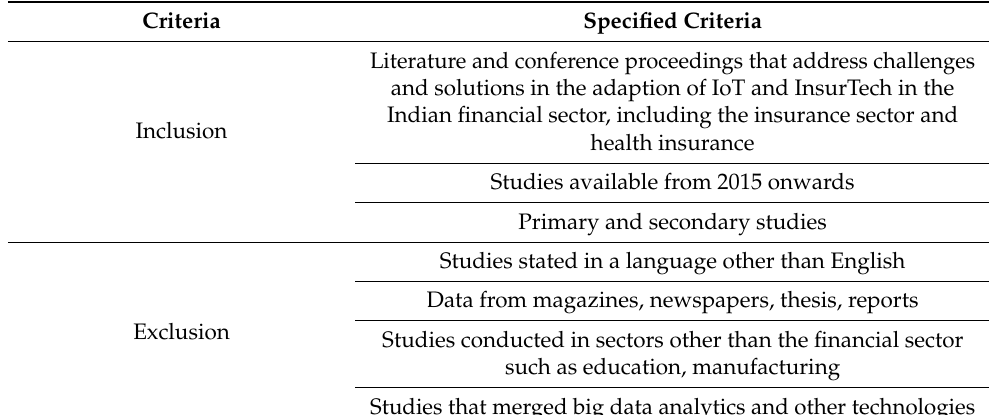
Figure 2. PRISMA (authors). Table 1. Inclusion/exclusion